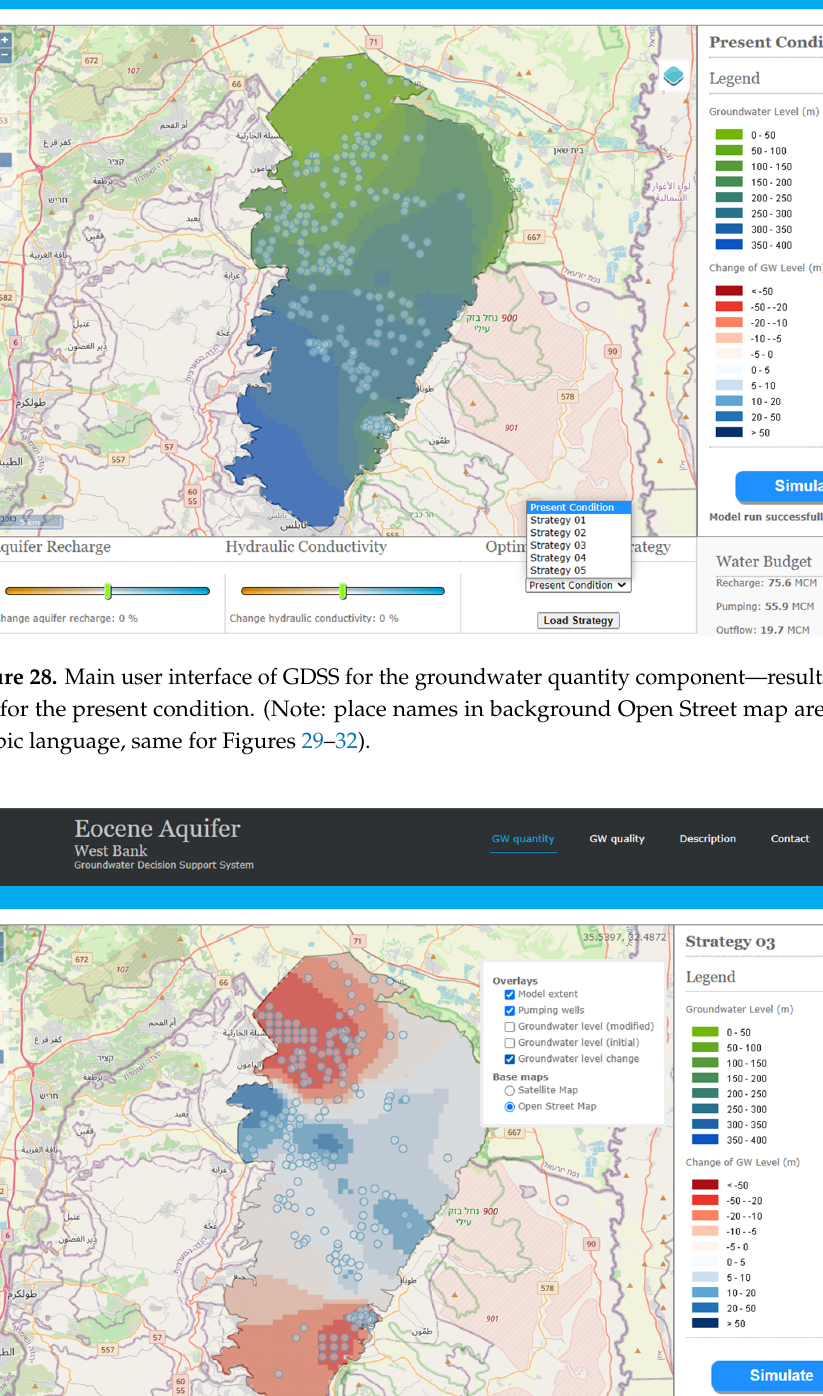
Figure 30. Wells capture zones for current conditions and for strategy 03.